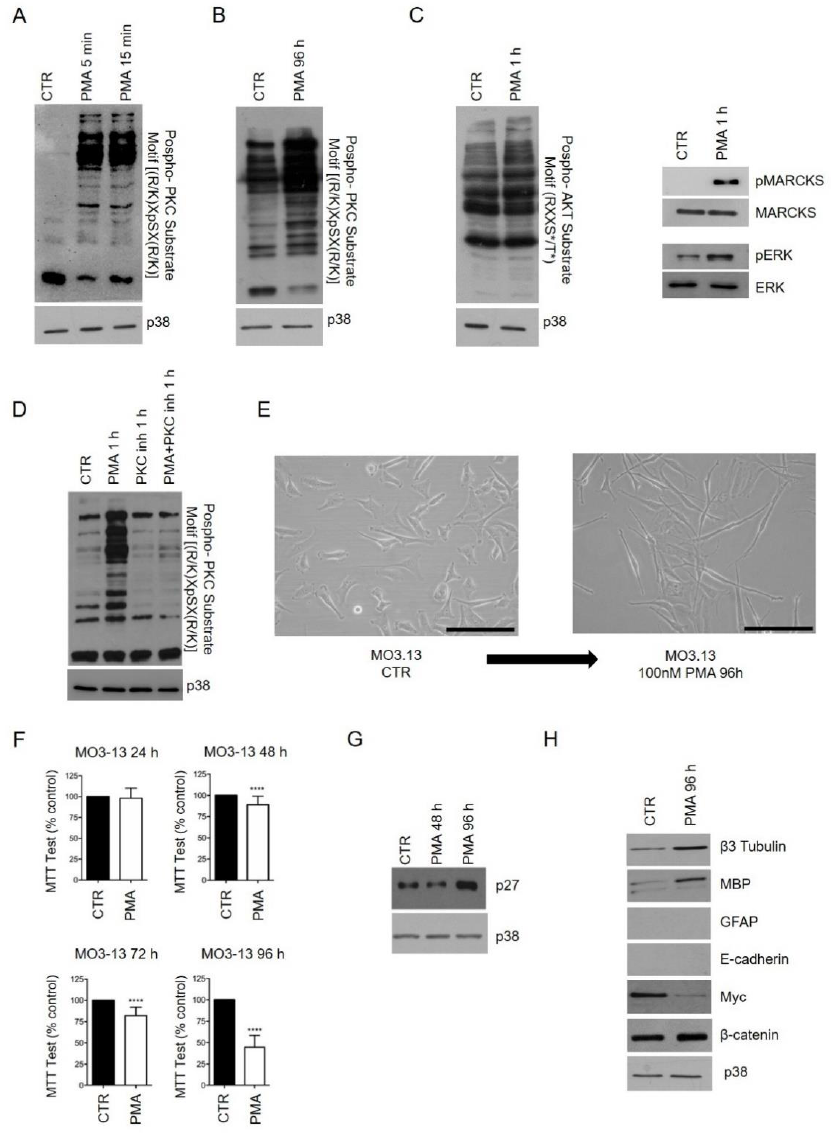
Figure 1. Phorbol 12-Myristate 13-Acetate (PMA) treatment induces phospho-protein kinase C (PKC) activation and MO3.13 differentiation. ( A ) Western blot analysis showing the activation rate of PKC substrates in MO3.13 cells after 100 nM PMA short-term treatment (5 min and 15 min). An anti-phospho-PKC substrate motif ((R/K)XpSX(R/K)) antibody was used. This antibody specifically detects endogenous levels of cellular proteins only when phosphorylated at Ser residues (S) surrounded by Arg (R) or Lys (K) at the − 2 and + 2 positions. p38 was used as a loading control. ( B ) Western blot analysis exhibiting the activation degree of PKC substrates after 96 h of PMA treatment compared to the control (CTR). p38 was used as a loading control. ( C ) Western blot analysis reporting the activation rate of AKT substrates, MARCKS and ERK proteins at 1 h of PMA treatment. ( D ) Western blot analysis reporting the activation of PKC substrates in MO3.13 cells, after treatment with PMA and Ro 31-8220 (1 µ M) used alone and in combination for 1 h. p38 was used as a loading control. ( E ) Representative images of MO3.13 cells cultured in a normal condition medium (left) or treated with 100 nM PMA (right) for 96 h. Images were acquired using an inverted wide-field microscope (Olympus IX51). Scale bar 200 µ m. ( F ) MO3.13 cell proliferation assessed by MTT test for 24 h, 48 h, 72 h and 96 h. Data were represented as the number of viable cells compared to the CTR, expressed as mean ± standard deviation (SD). **** p -value < 0.0001 by t -test. ( G ) Western blot analysis was performed on the whole-cell lysate using an anti-p27 antibody in MO3.13 cells treated with PMA for 48 h and 96 h. p38 was used as a loading control. ( H ) Western blot analyses using anti- β -tubulin3, anti-MBP, anti-GFAP, anti-E-cadherin, anti-Myc and anti- β -catenin antibodies were performed on the whole protein extract of MO3.13, CTR and treated conditions. p38 was used as a loading control. Western blot experiments were performed in